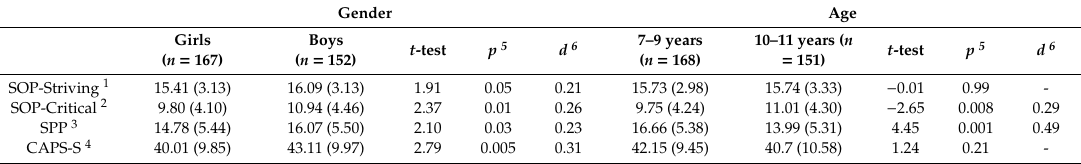
Table 3. Mean (Standard Deviation) for CAPS-S and its subscales according to gender and age. Gender Age Girls Boys 5 d 6 ( n = 167) ( n = 152) t -test p